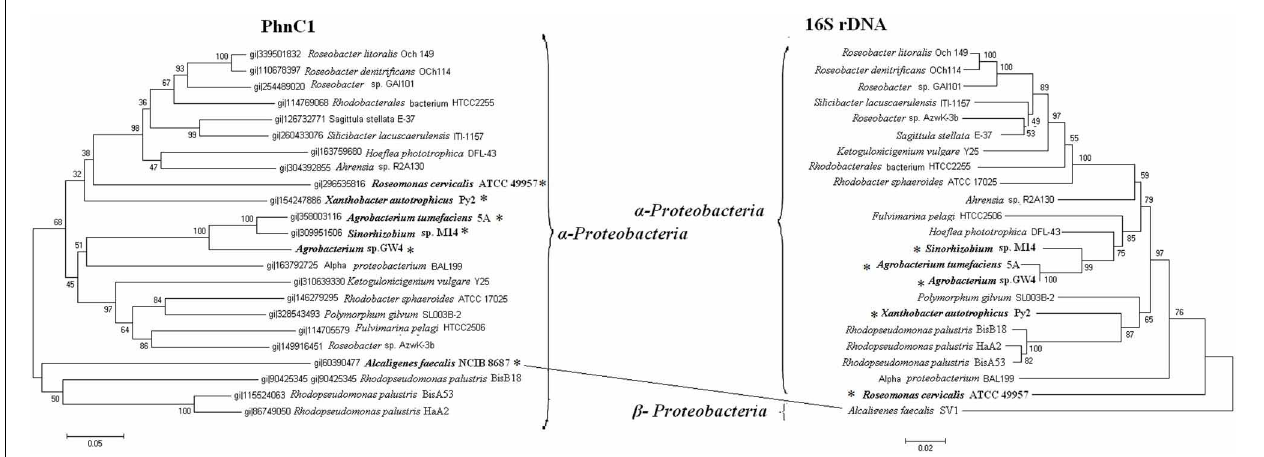
transfer events (connected lines) have been compared based on the inconsistency of the amino acid sequence tree (on the left) and the 16S rDNA tree (on the right).